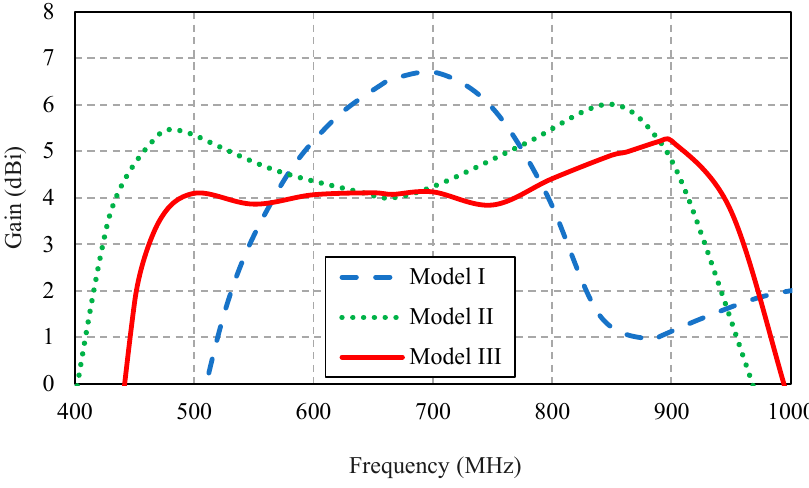
Figure 5. The simulated antenna gains of models I, II, and III.